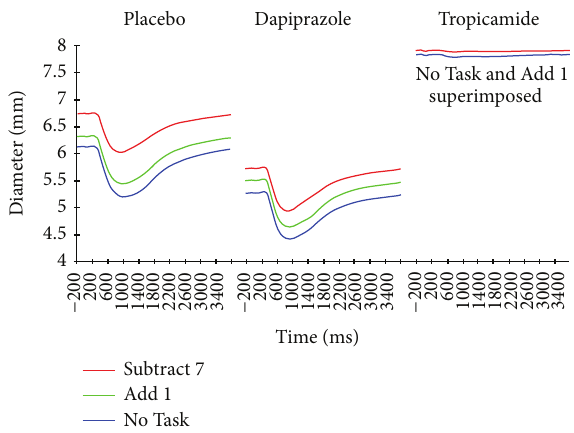
Figure 1: Average pupillary response to light stimuli 2–11 for 29 subjects. Columns represent separate placebo, dapiprazole, and tropicamide instillations. Conditions are No Task (blue line), Add 1 (green line), and Subtract 7 (red line). Note that the No Task and Add 1 conditions are completely superimposed for the tropicamide administration. Light stimulus duration was from 0 to 1000